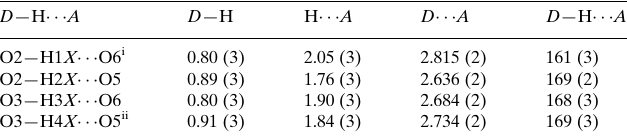
Hydrogen-bond geometry (A˚ , (cid:3)